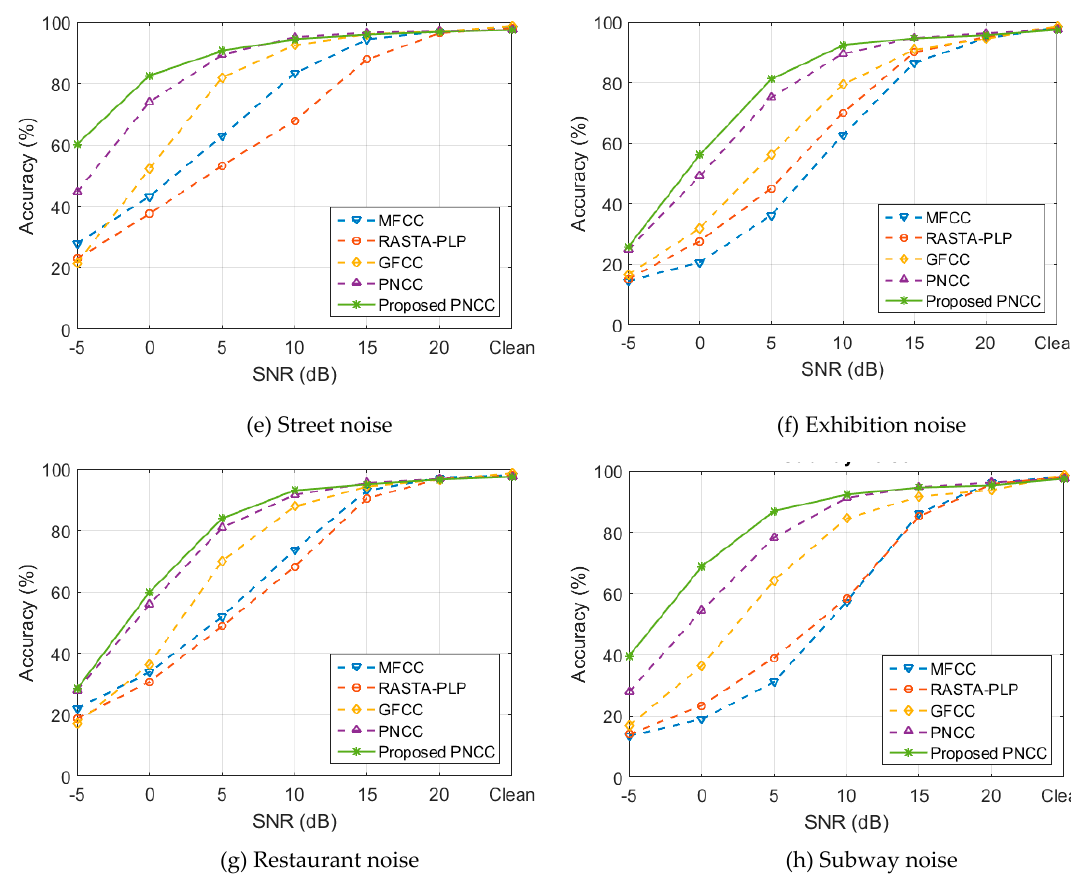
Figure 4. Percentage recognition accuracy under various noise conditions.